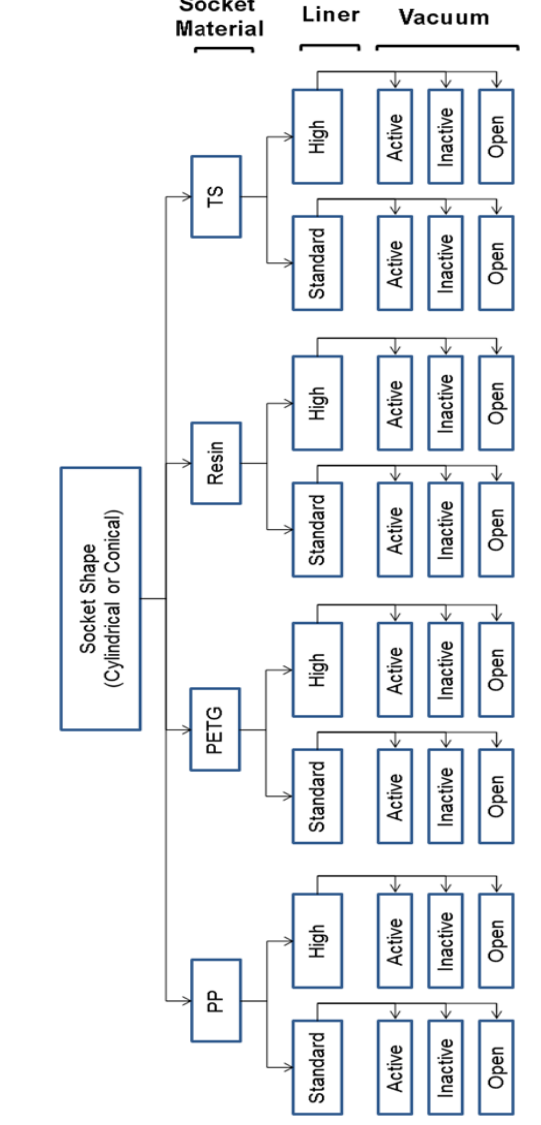
Figure 3: Tensile tests (48 combinations). PP (polypropylene); PETG (polyethylene terephthalate glycol-modified); Resin (thermoset resin); TS (Thermolyn